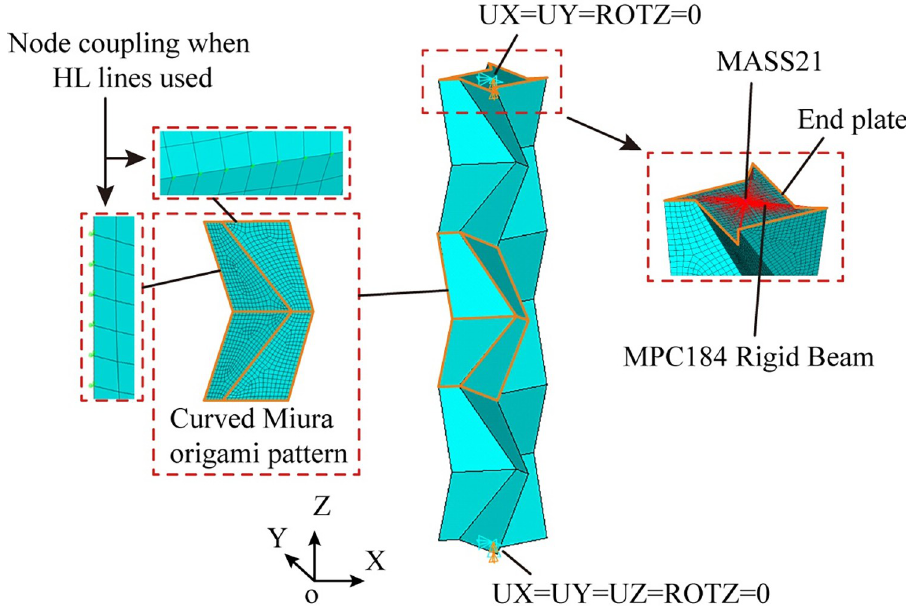
Fig 7. Modelling of a 3-level patterned tube.